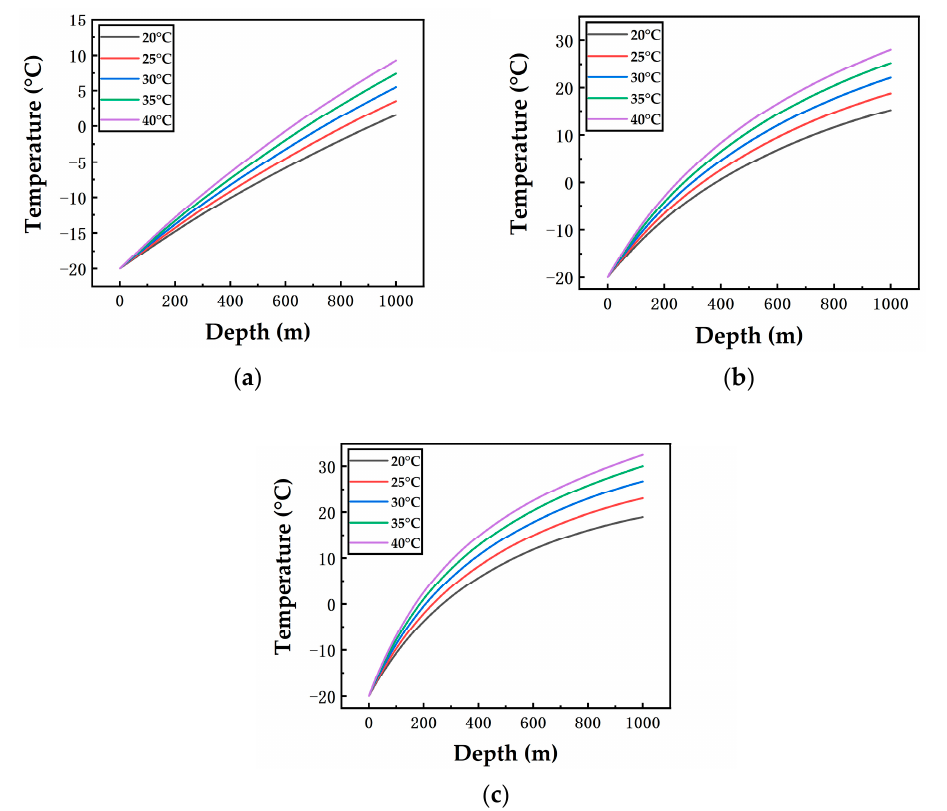
Figure 4. Variation of the on-way temperature with the depth in the vertical pipeline at different ambient temperatures and airflow velocities (( a ): 1 m/s; ( b ): 7.5 m/s; ( c ): 15 m/s).